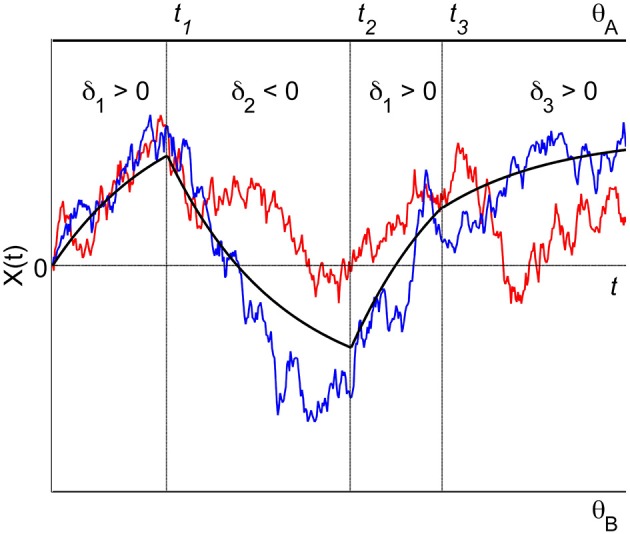
A piecewise Ornstein-Uhlenbeck process with three different attributes. The attribute order is (1, 2, 1, 3), attribute 1 is considered twice in the sequence of attribute consideration. Switching attention from one attribute to the next occurs at fixed times t1, t2, and t3. The trajectories reflect the accumulation process for two different trials. The black solid lines indicate the effective drift of the process.